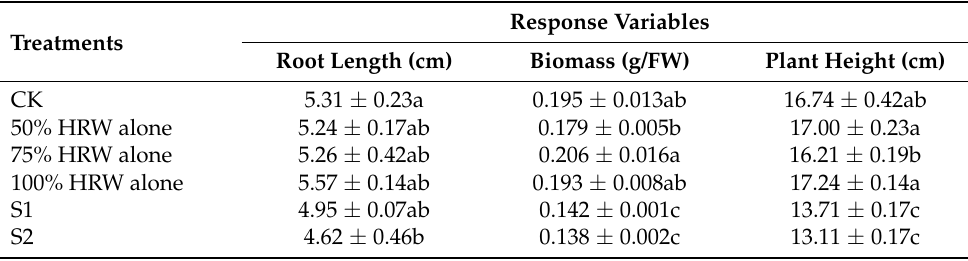
Table 2. Effects of the herbicide BS (Bispyribac-sodium) and HRW (hydrogen-rich water) on root length, biomass, and plant height of japonica rice (at five days post